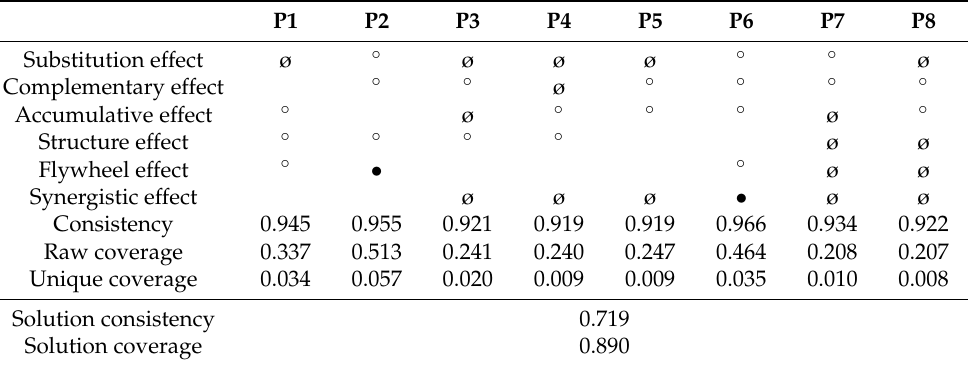
Table 6. Antecedent variable structure of effects of the digital economy on agricultural labor force